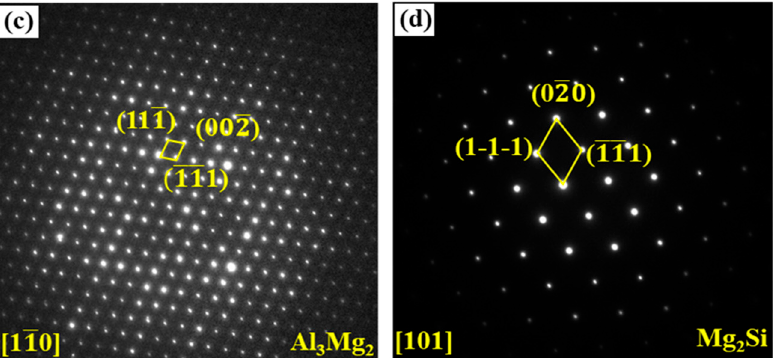
Figure 8. TEM analysis results of layer I in the Mg–Al interface: ( a , b ) TEM bright-field images; ( c ) SAED pattern of the Al 3 Mg 2 phase; ( d ) SAED pattern of the Mg 2 Si phase.